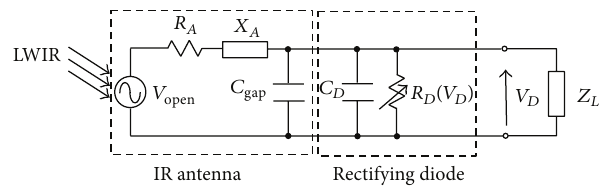
Figure 2: Circuit model of IR antenna coupled to rectifying diode.